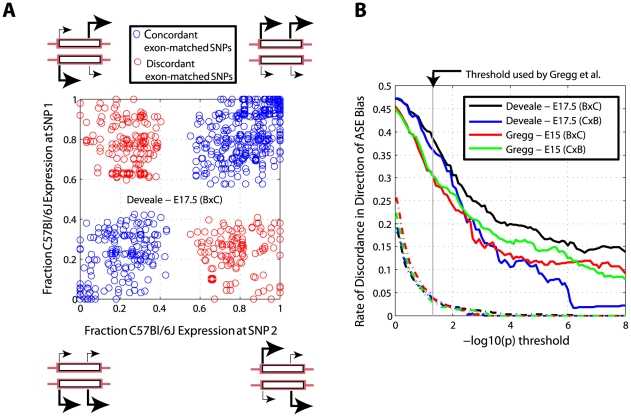
Direction of allele-specific expression bias measured at SNPs in the same exon disagrees more frequently than expected by chance.(A) Expression bias at 1,388 pairs of SNPs under ASE (chi-square p<1e-4 for both SNPs) disagrees in direction for 20.0% of pairs in E17.5 BxC data. (B) Discordance improves with increasing p-value thresholds but is higher than simulated data where allelic counts for one SNP in each pair are randomly sampled from the χ
2 distribution (broken lines; see Materials and Methods).